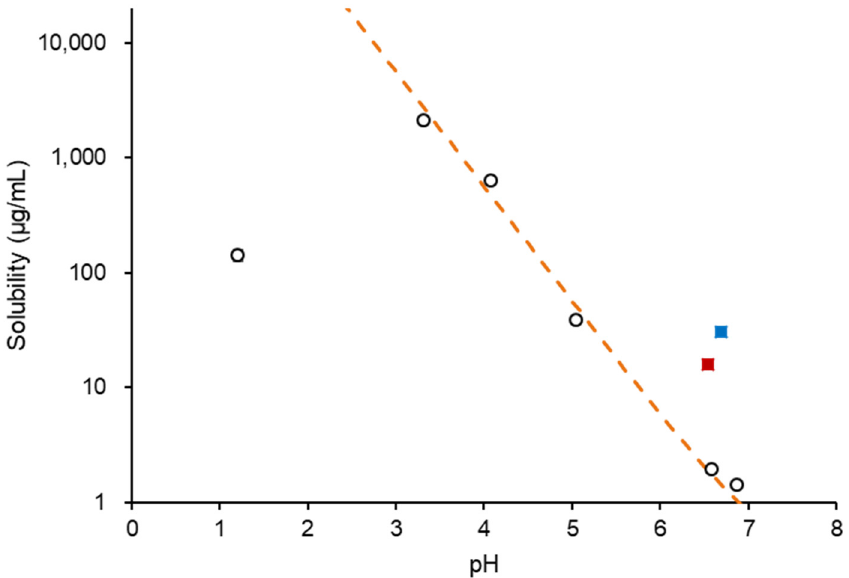
Figure 1. pH-solubility profile of NFT. ( ○ ) Buffered solutions, ( ■ ) 3 mM SIF, and ( ■ ) 15 mM SIF. Table 1. Solubility of NFT in polymer solutions ( μ g/mL).